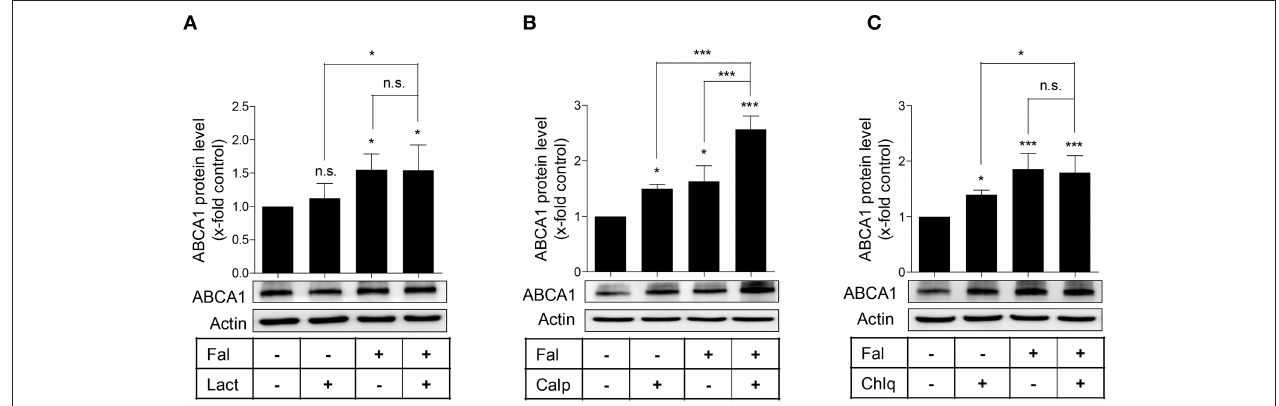
FIGURE 5 | Effect of specific inhibitors of the proteasome (A) calpain (B) , and lysosomal (C) protein degradation pathways on ABCA1 protein level in the presence or absence of falcarindiol. Differentiated THP-1 macrophages were pre-treated with or without falcarindiol (Fal) at 10 µ M for 24 h and incubated for another 3 h with the proteasome inhibitor lactacystin (Lact) at 10 µ M (A) , the calpain inhibitor calpeptin (Calp) at 30 µ g/mL (B) , or the lysosomal inhibitor chloroquine (Chlq) at 100 µ M (C) . Cells were lysed and protein was resolved via SDS-PAGE. Western blot analysis was used to monitor ABCA1 protein level under the indicated treatment conditions. All data are mean ± SD ( n = 4) and vs. solvent vehicle control (DMSO): * p < 0.05, *** p < 0.001, n.s. not significant (one-way ANOVA/Bonferroni).